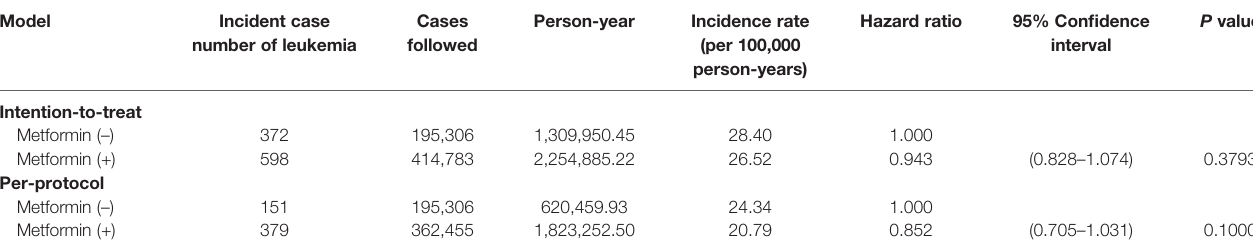
TABLE 2 | Incidence rates of leukemia and hazard ratios comparing metformin initiators versus non-metformin initiators.